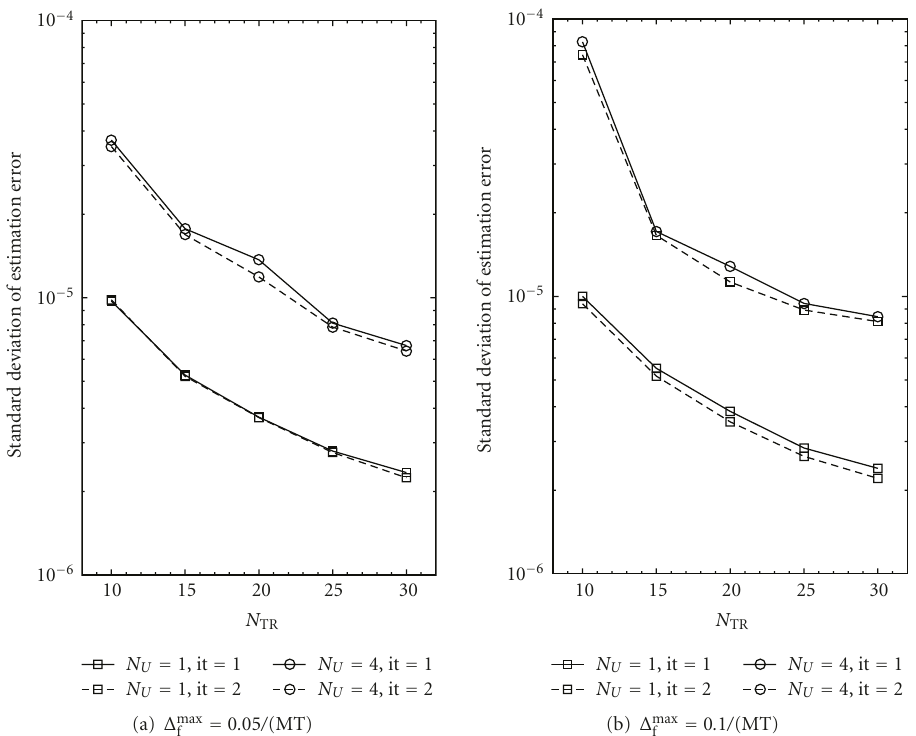
Figure 4: Standard deviation of the frequency o ff set estimation error as a function of the training sequence length. Metric (24) for the US-RX for di ff erent values of Δ max . SNR is equal to 20 dB. f